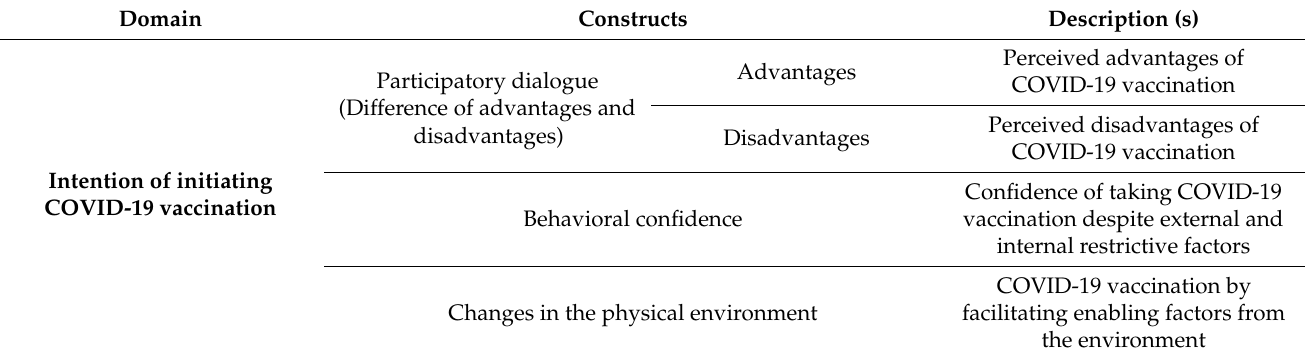
Table 1. Theoretical framework of Multi-level Theory Model explaining the initiation of COVID-19 vaccination.